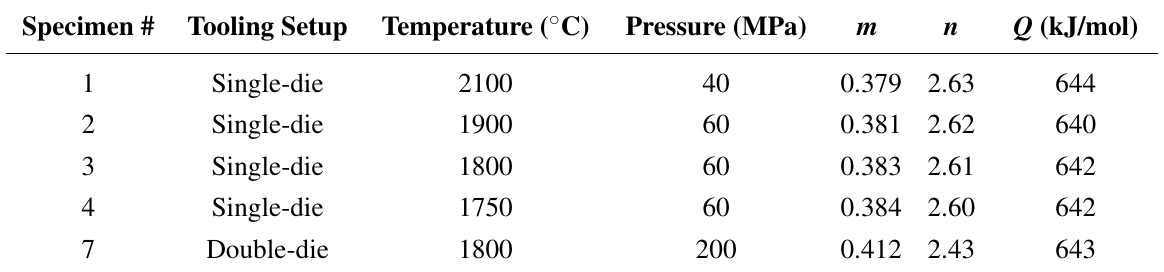
Table 3. Creep coefficients obtained from inverse regression of experimental data.